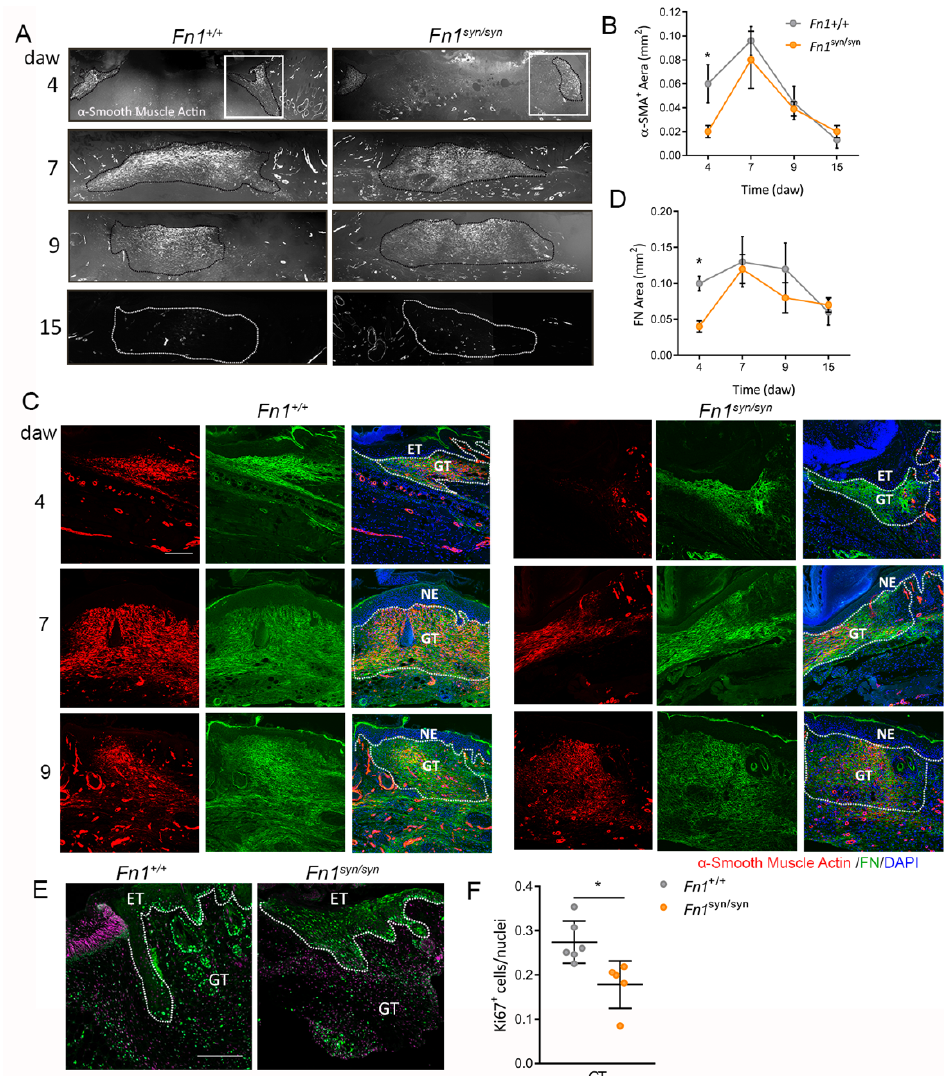
Figure 3. Fn1 syn/syn wounds are less fibrotic. ( A ) Representative immunofluorescence of α -SMA-positive cells in the GT area (delimited by dotted line) at different time points. ( B ) Quantification of α -smooth muscle-positive areas in wounds from Fn1 +/+ and Fn1 syn/syn mice. ( C ) Representative images from FN (green) distribution and α -SMA-positive cells (red) in Fn1 +/+ and Fn1 syn/syn wounds at 4, 7 and 9 daw. ( D ) Quantification of FN area in the GT region of wounds from Fn1 +/+ and Fn1 syn/syn mice ( n = 12, 12 (4) n = 14, 12 (7) n = 11, 11 (9)). ( E ) Representative immunofluorescence of Ki67 immunostaining (green) and Dapi (purple) in Fn1 +/+ and Fn1 syn/syn wounds at 4 daw. ( F ) Quantification of the proportion of Ki67-positive cells. Statistical analysis was performed using Student t -test. p -value * p < 0.05. Scale bars, 40 µ M ( C ) and 200 µ M ( E ). ET; epithelial tongue, GT; granulation tissue, NE, new